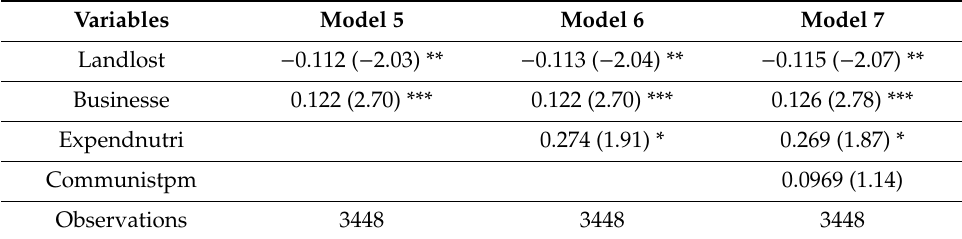
Table 4. Robustness of estimating health status: adding some other control variables.